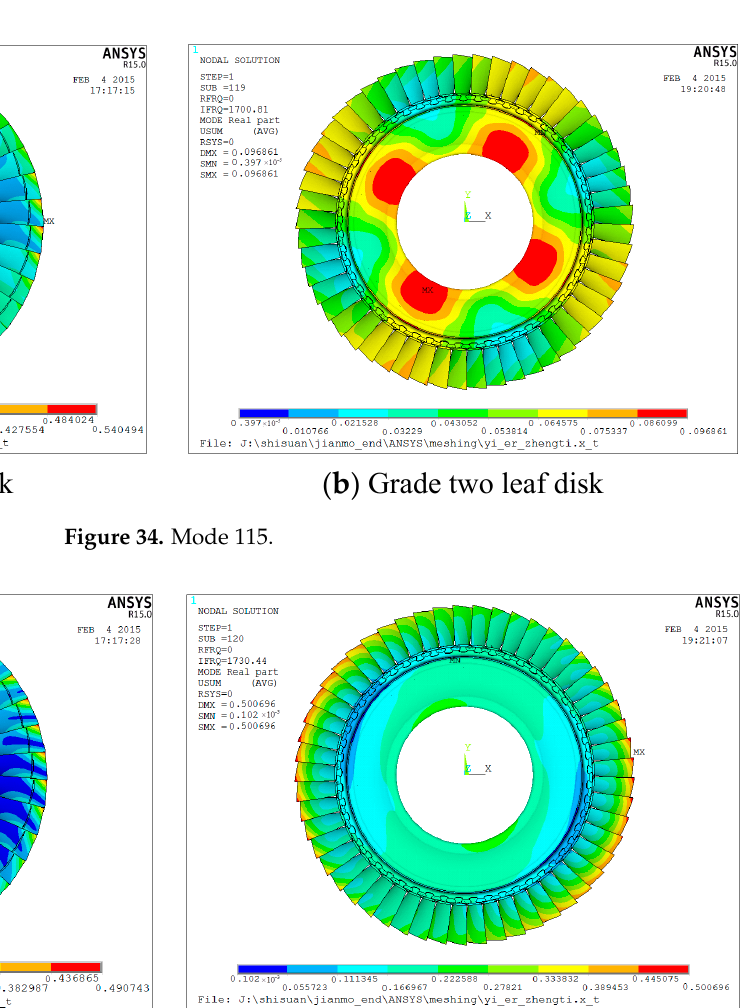
Figure 33. Mode 106.